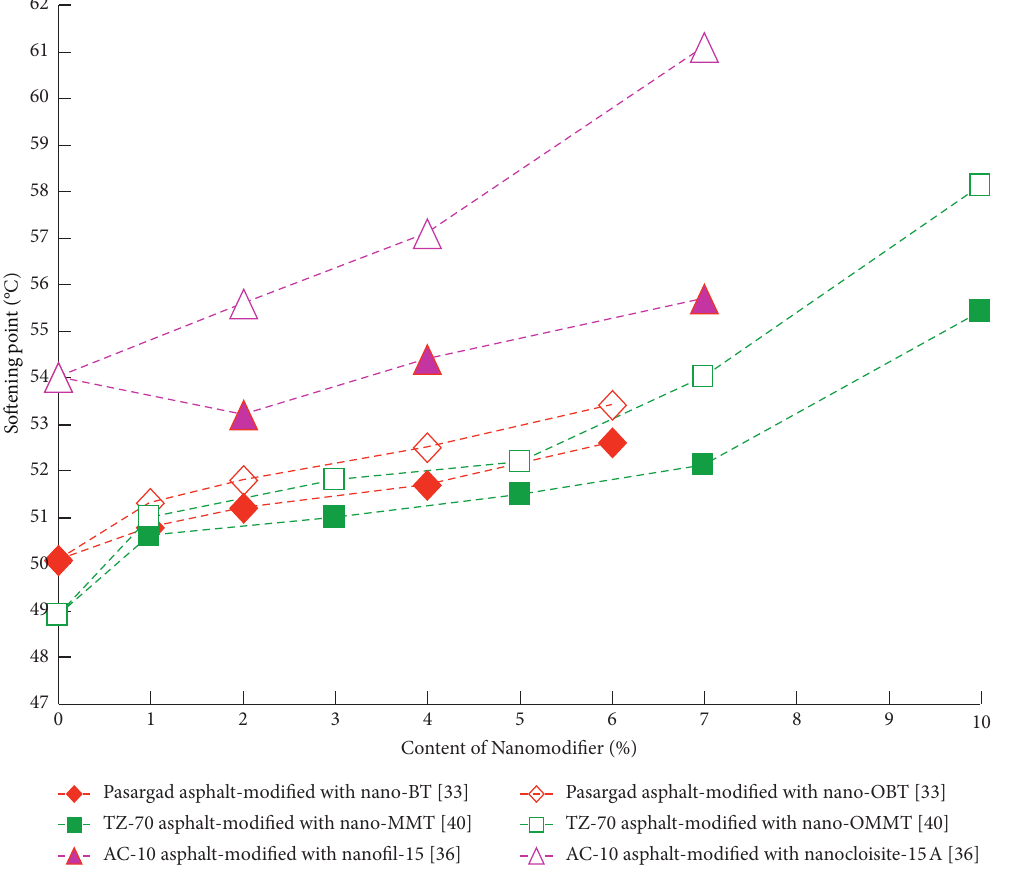
Figure 5: Softening point of nanomodified